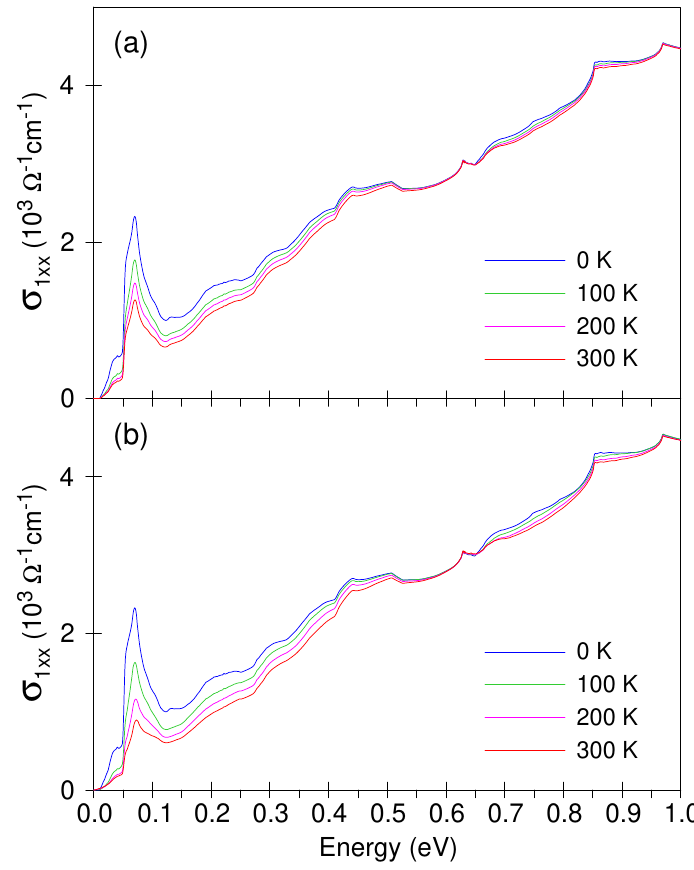
Figure 5. Temperature dependence of the optical conductivity calculated ( a ) by multiplying the interband transition probabilities with the Fermi-Dirac function and ( b ) using the Mott